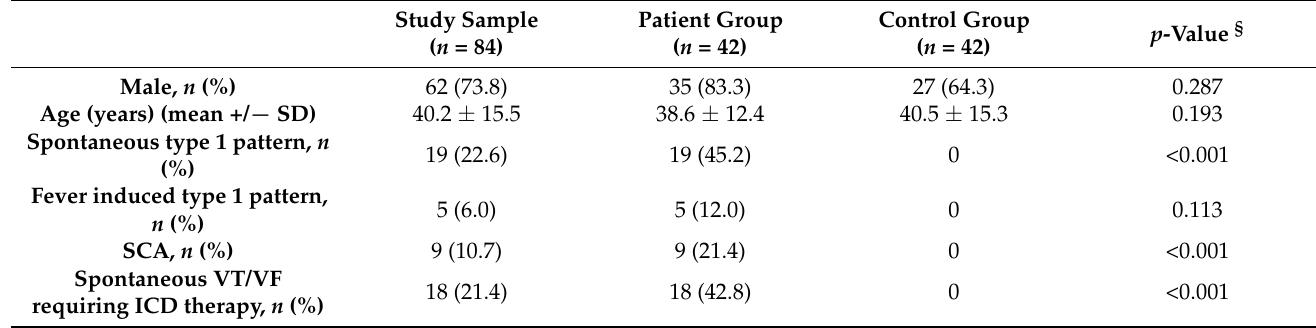
Table 1. Clinical characteristics of the study